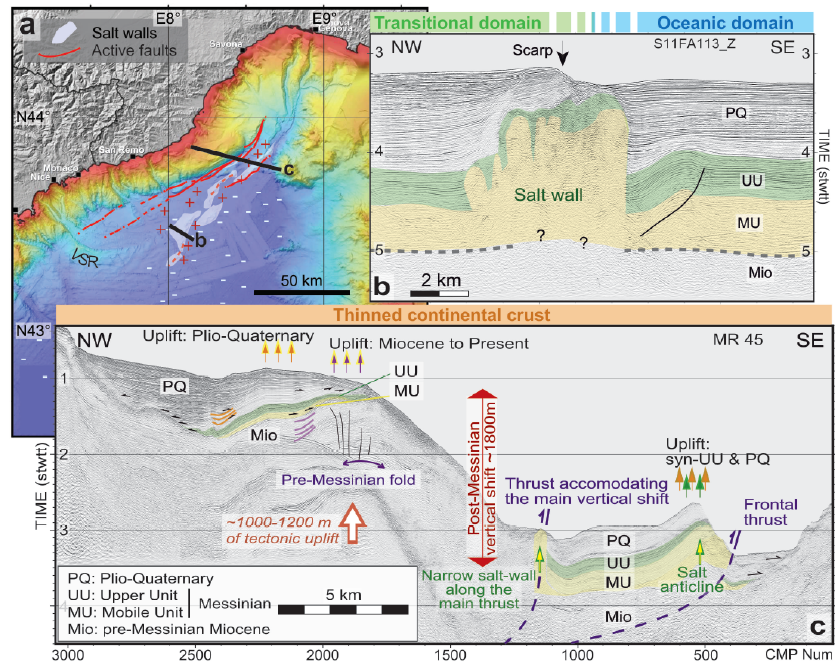
Figure 2. Results from previous shallow seismic studies in the Ligurian Sea. ( a ) Bathymetric map with active inversion-related structural features (modified from [4]): red lines for active reverse faults identified at the slope’s toe, pale patches for salt walls in the deep basin; b and c stand for the surface trace of the profiles displayed in the two other panels of the figure; VSR: Var Sedimentary Ridge. ( b ) Salt walls in the basin, most likely resulting from interference between salt and deeper crustal tectonics [11]. ( c ) Active reverse faults (thick dashed lines) below the eastern margin, o ff shore Imperia, most likely responsible for its ≥ 1000-m uplift there, marked by the o ff set (double red arrow) in the Messinian series (in green / yellow for Upper / Mobile ones, modified from [11]). ( b , c ) are from high-resolution FABLES [11] and MALISAR [4] reflection seismic data, respectively. Basement domains are indicated [10].